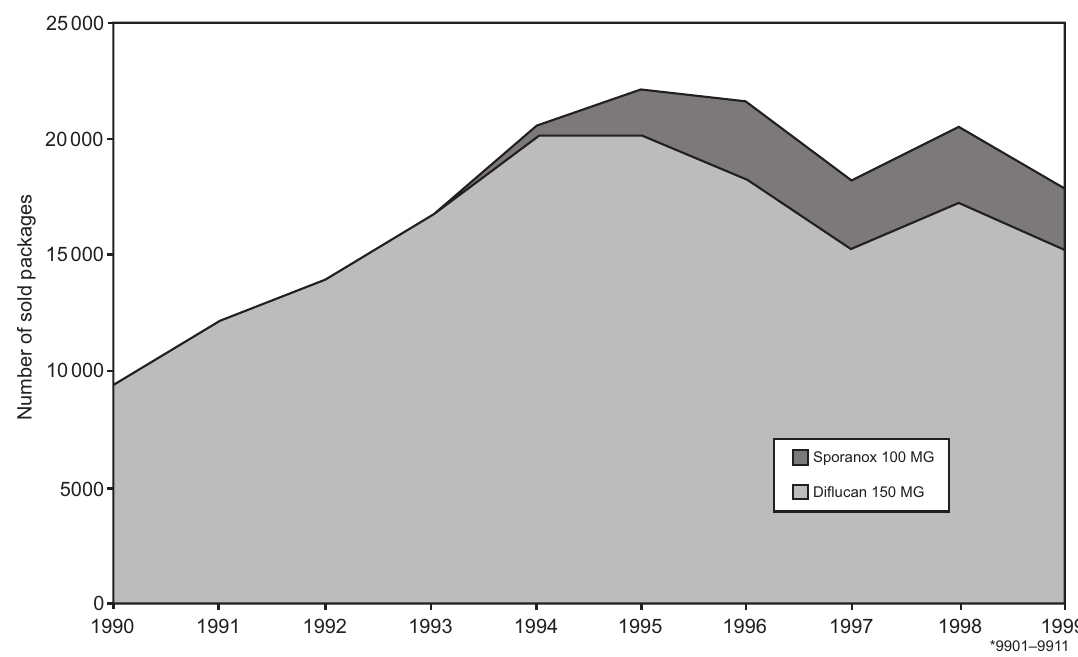
Figure 2 Number of prescriptions of 150 mg (single-dose) fluconazole (Diflucan 1 ) and of four capsules of 100 mg itraconazole (Sporanox 1 ), with genital Candida infection in females as the sole indication, sold in Ska˚ne county, Sweden, during the